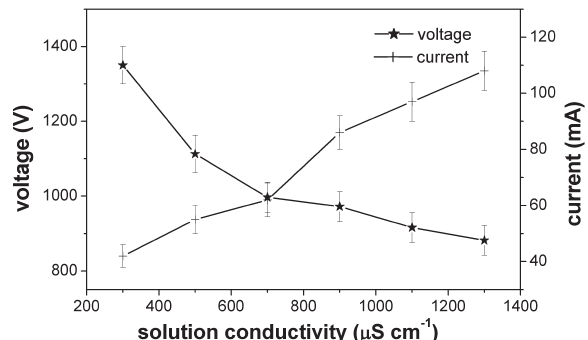
Figure 6: Minimal applied voltage and current for the DC discharge breakdown as a function of solution conductivity; NaCl solution, ratio of dielectric barrier thickness and pin-hole diameter equals approximately